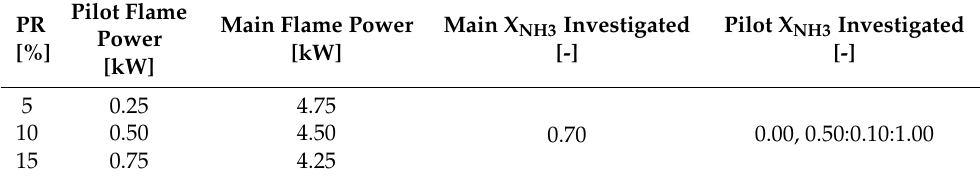
Table 1. Pilot X NH3 test